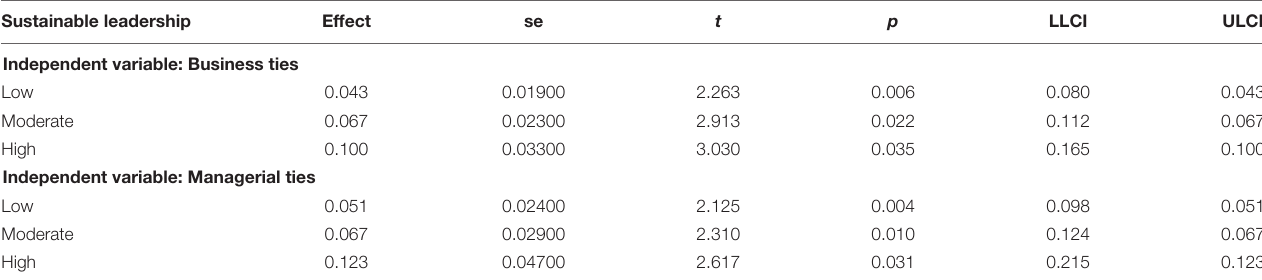
TABLE 6 | Conditional effects of the independent variables at values of the moderator(s). Sustainable leadership Effect se t p LLCI